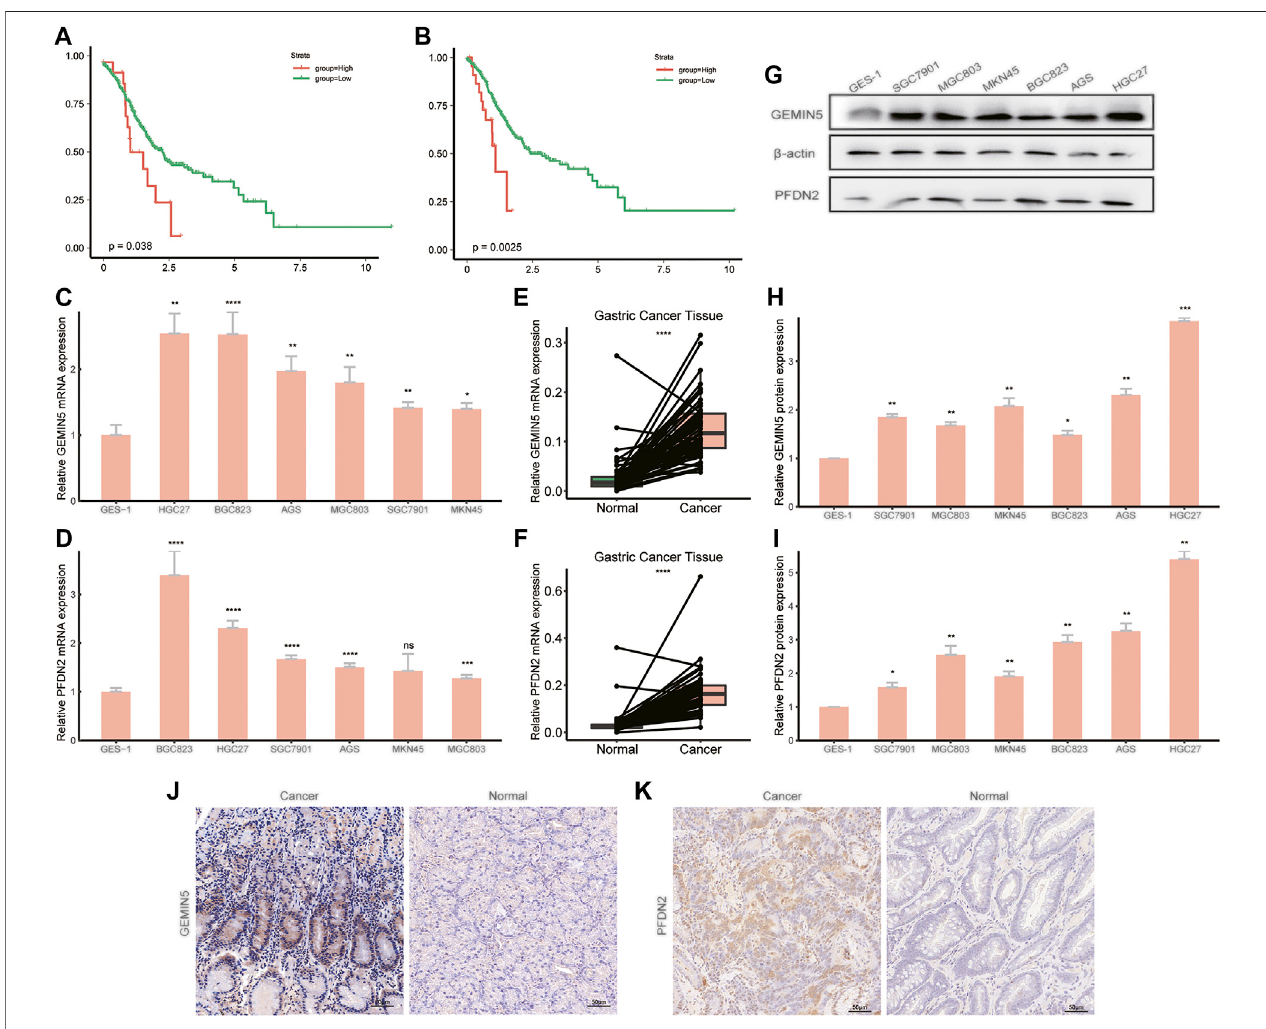
FIGURE 6 | Validation of the key genes using TCGA-STAD data and laboratory experiments. Kaplan-Meier curve analysis of GEMIN5 (A) and PFDN2 (B) was shown.ExpressionofGEMIN5andPFDN2mRNAlevelswerevalidatedbyRT-qPCRincelllines (C) – (D) andpatientsamples (E) – (F) .ExpressionofGEMIN5andPFDN2 protein levels were validated by western blot (G – I) and immunohistochemistry (J – K) . Both mRNA and protein expression level of GEMIN5 and PFDN2 were higher in tumor samples and cancer cell lines than in normal samples and nontumorigenic cell line.